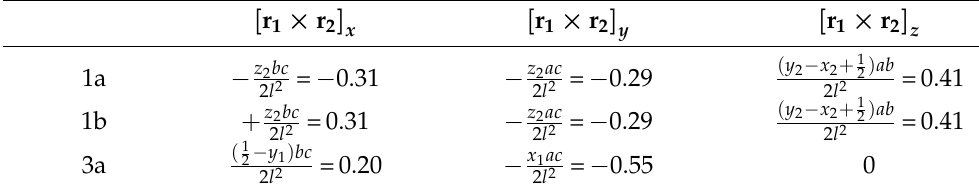
Table 3. The structural factors [ r 1 × r 2 ] for the superexchange coupled Fe-O-Fe pairs in orthofer- x , y , z rites with numerical values for YFeO 3 . See text for details.